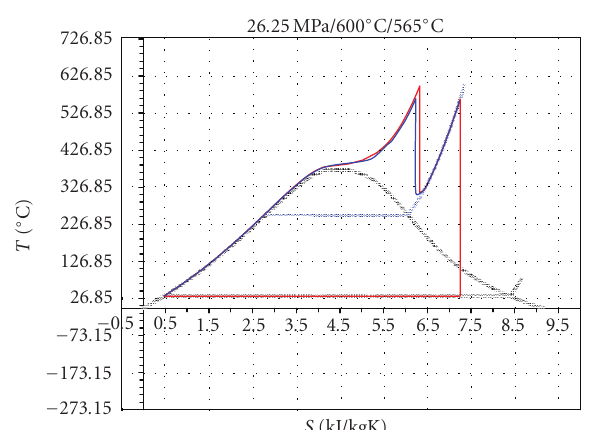
Figure 6: Ideal T - S diagram of life-steam reheat SC turbine cycle with 26.25 MPa/600 ◦ C/565 ◦ C.